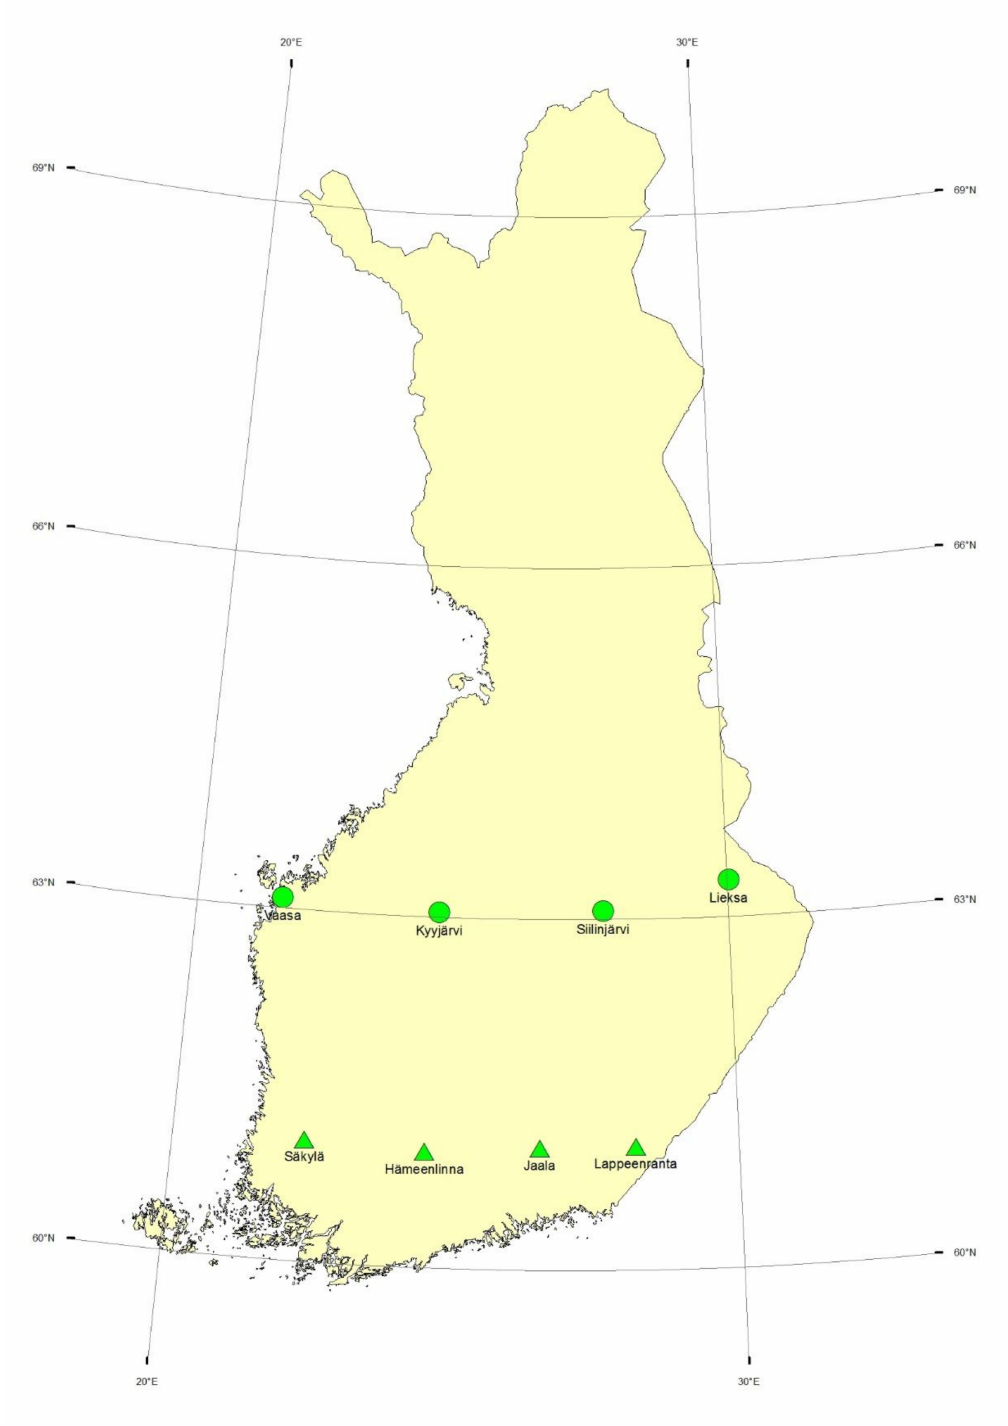
Figure 1. Locations of the eight simulated pine stands in southern Finland. The triangles refer to Region 1 and the circles refer to Region 2, as referred in the main